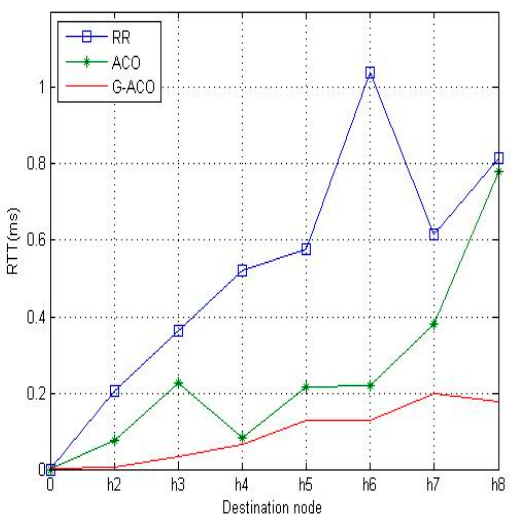
Figure 9. The comparison of RTTs with 10-minute simulation time.